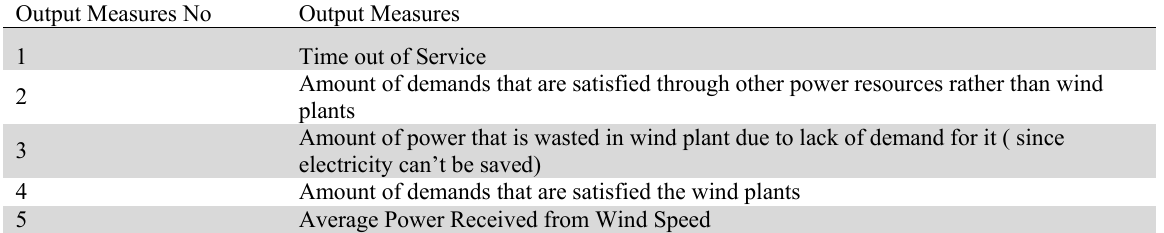
The output measures of the simulation